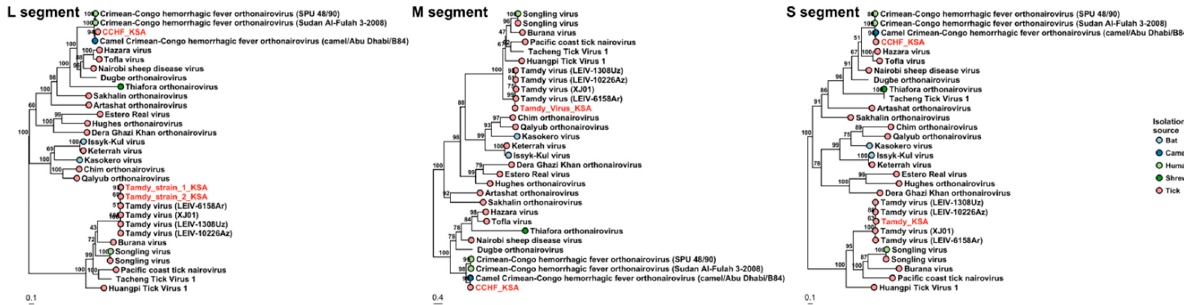
Figure 3. Phylogenetic trees based on L, M and S segments of nairoviruses. The viruses detected in Saudi Arabia are marked with red color.